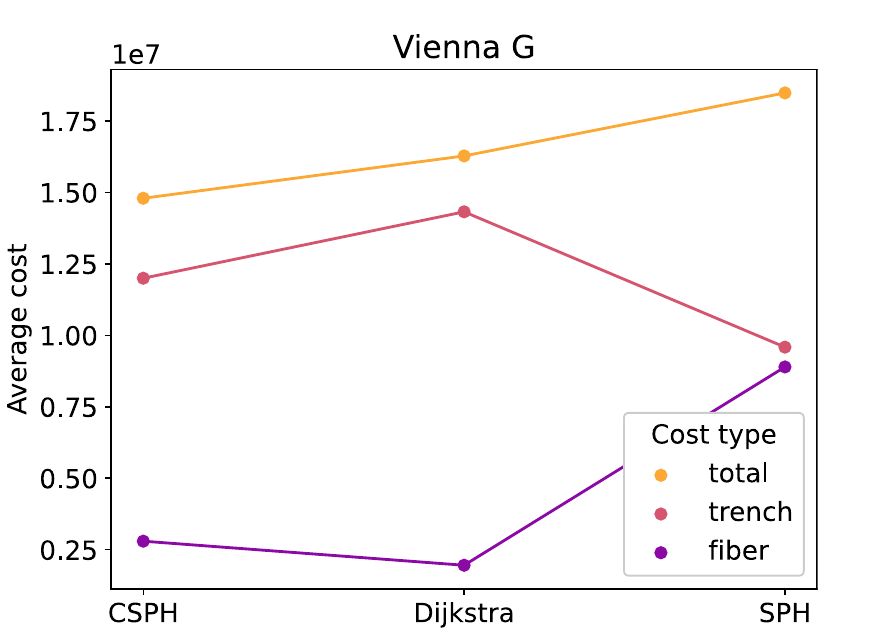
Fig 2. Vienna G cost type analysis. Different cost types (fiber, trench and total) for the CSPH, Dijkstra and SPH algorithms.